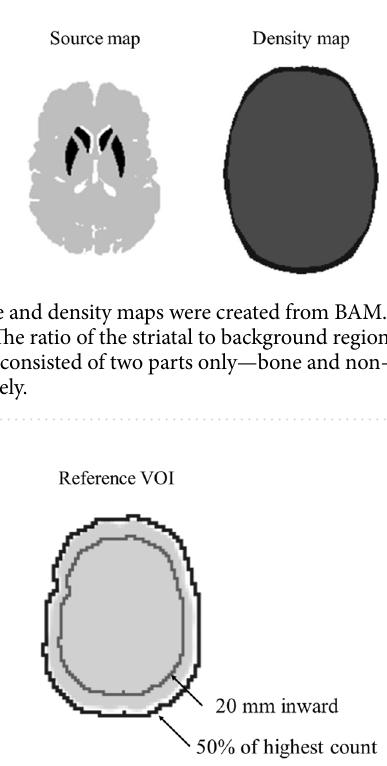
Figure 4. Schematic diagram of VOI setting. The unit of the striatal VOI is mm. The reference VOI was set to background regions, and it was then smoothed except for the striatal